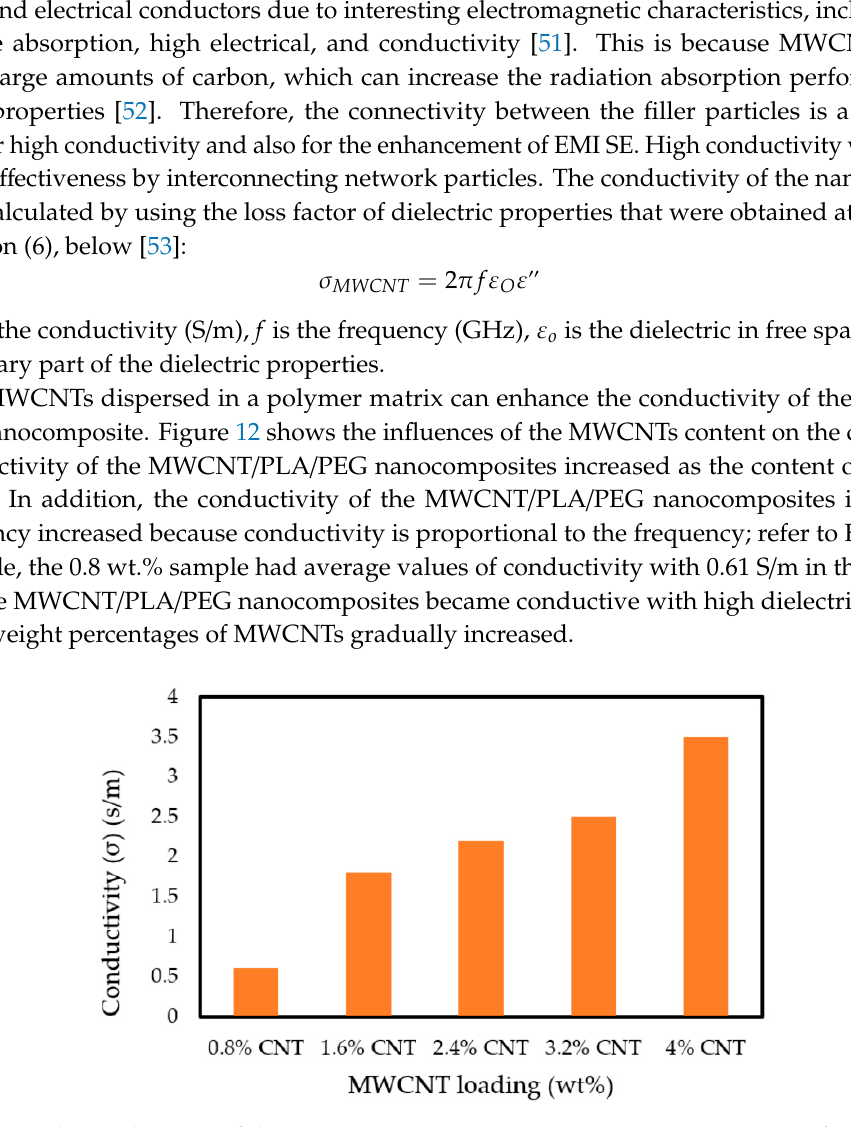
Figure 12. The conductivity of the MWCNT / PLA / PEG nanocomposites specimens as a function of MWCNTs content.